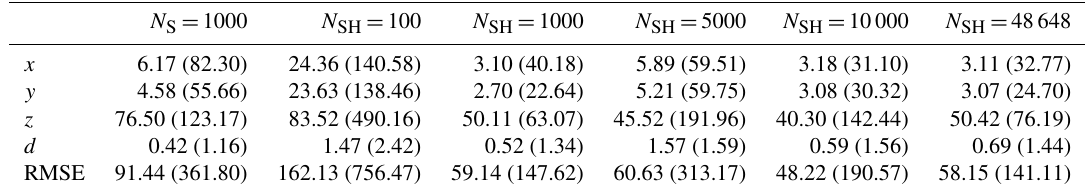
Table A3. The mean and standard deviation in the absolute error for each (x,y,z,d) , and RMSE. The metrics were computed using the test set of synthetic holograms. All reported values have units of µm.